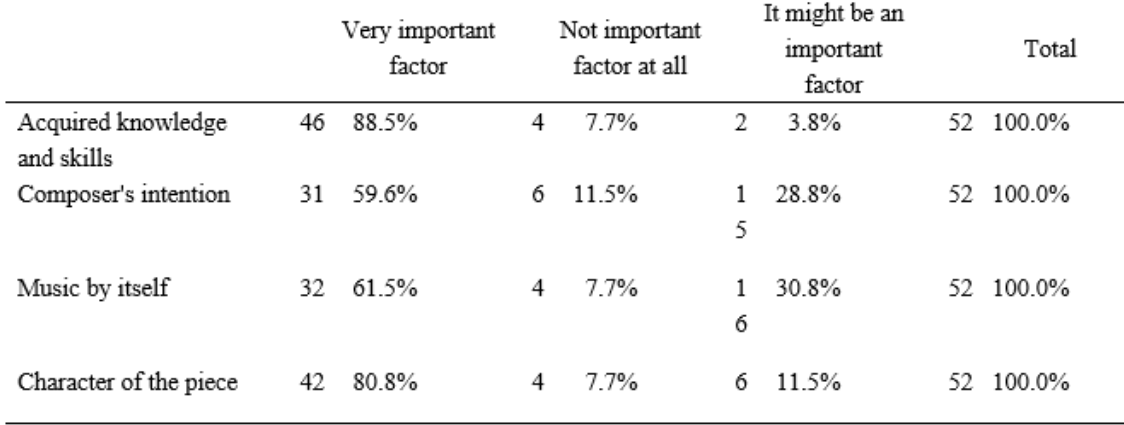
Table 4. Student's attitudes about the most significant factors that influence the way of interpretation of a musical piece